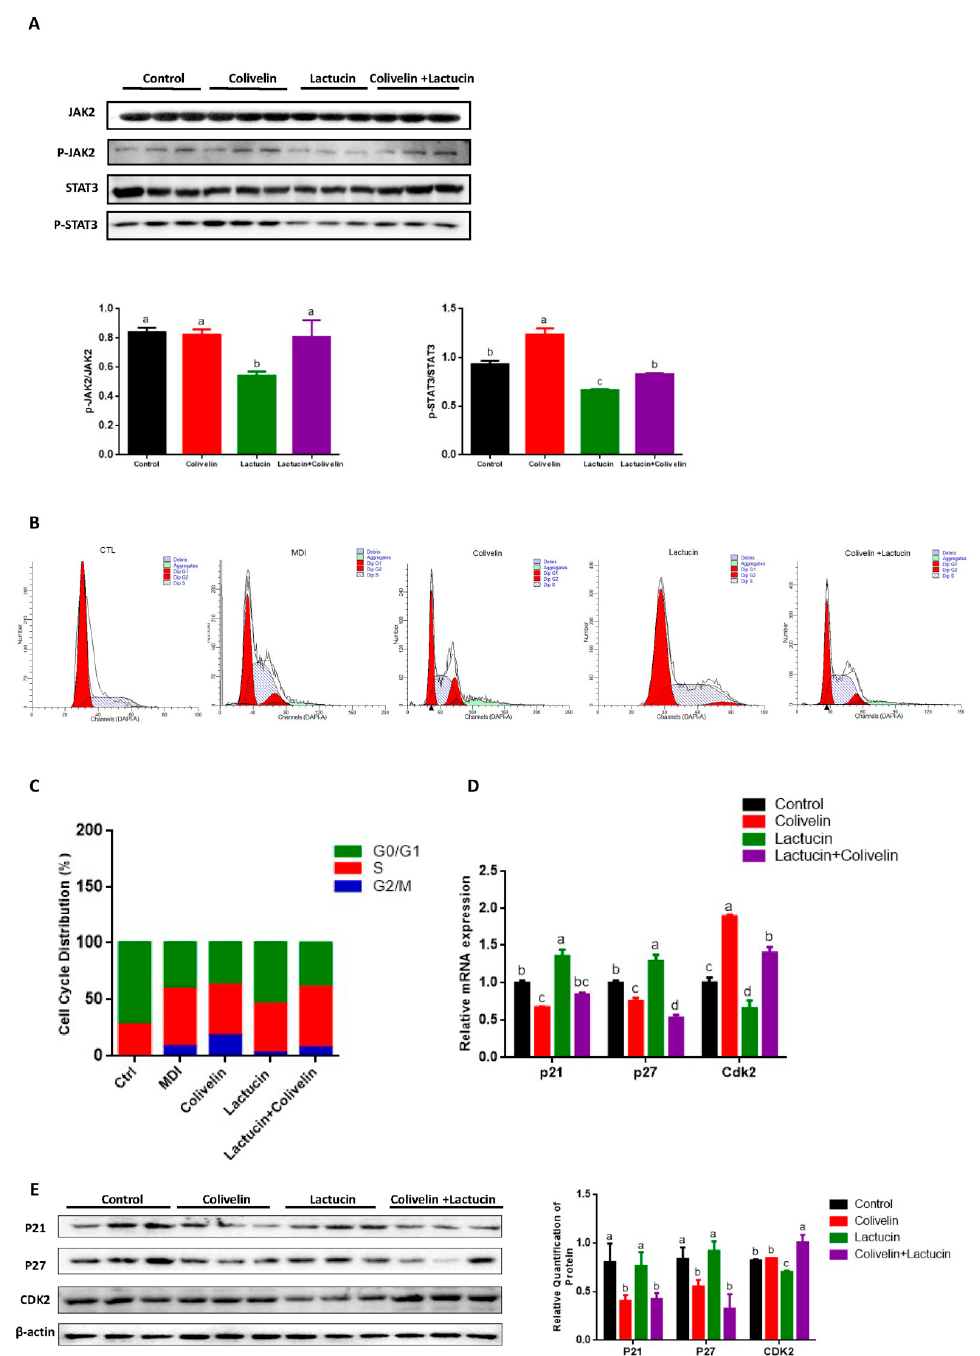
Figure 5. The pharmacological STAT3 activator reverses the cell cycle arrest of lactucin on 3T3-L1 cells. The 3T3-L1 preadipocytes were induced to di ff erentiate in the presence or absence of lactucin and colivelin for 24 h. ( A ) The immunoblot analysis of JAK2 / STAT3 signaling pathway in 3T3-L1 adipocytes after treatment ( n = 3). ( B ) The cell cycle analysis using flow cytometry. ( C ) Percentage of cells in G0 / G1, S and G2 / M phases measured using FlowJo V10 software. ( D , E ) The mRNA and protein levels of genes involved in cell cycle progression ( n = 3). Data expressed as mean ± SEM. Statistics were analyzed by ANOVA (Tukey multiple comparisons test), similar letters (a, b, c, d) indicate the absence of significant di ff